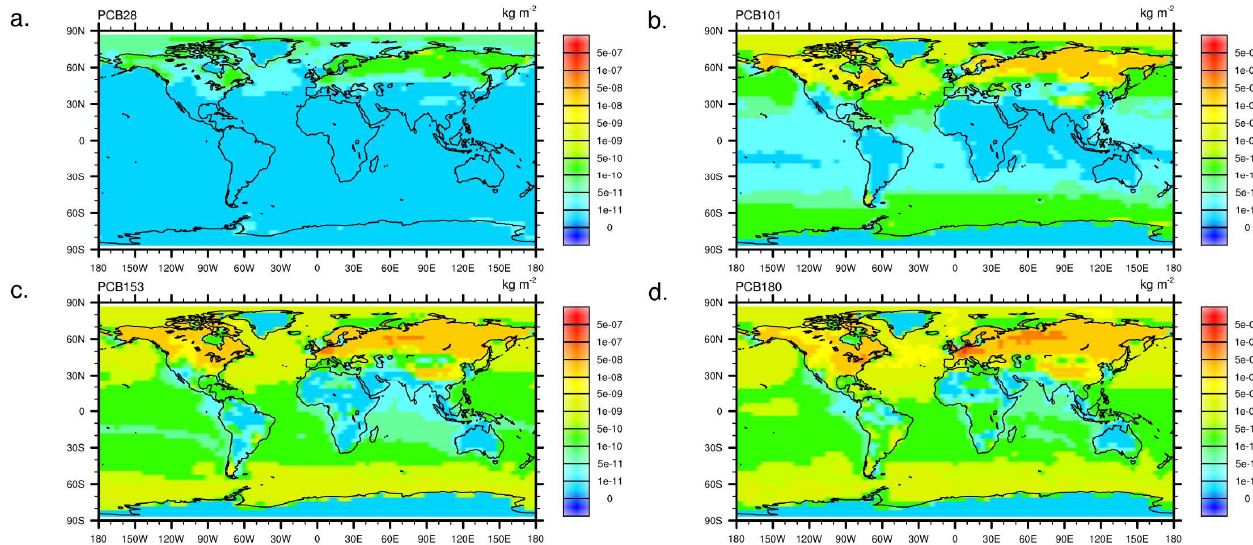
Fig. 1: Global distribution of the total environmental burdens of (a) PCB 28, (b) PCB101, (c) PCB153 and (d) PCB180 excluding the atmosphere (kg m -2 ). Mean of the year 2010.